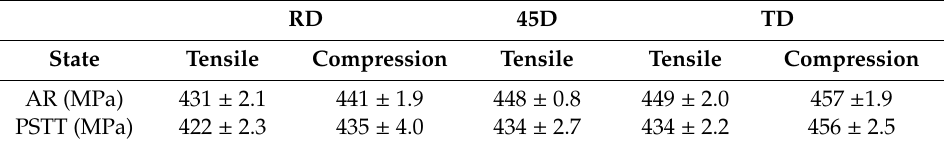
Table 5. Yield stress values of the Inco718 material under di ff erent directions and load conditions.